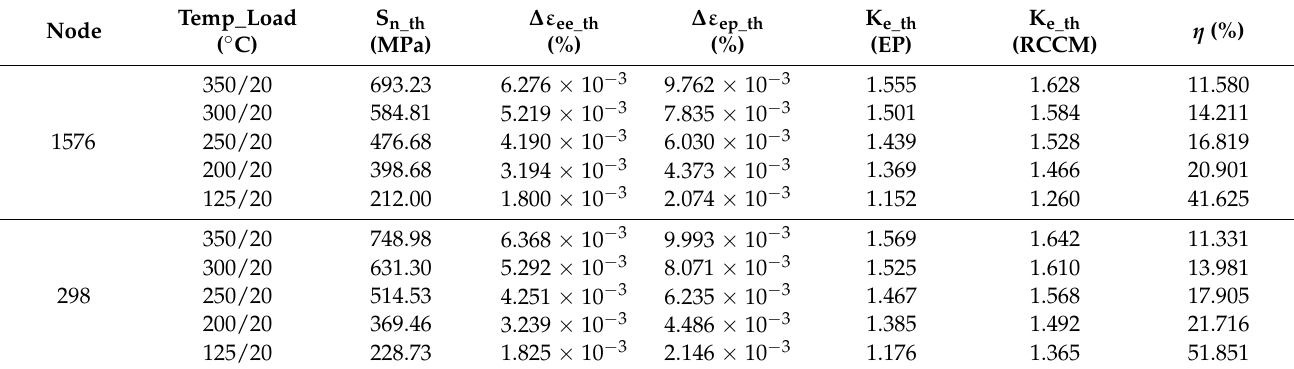
Figure 9. K e with S n under different temperatures with notched sheet model. Table 3. Results of K e under thermal load of Z2CND18.12 (nitrogen control) for nozzle model.